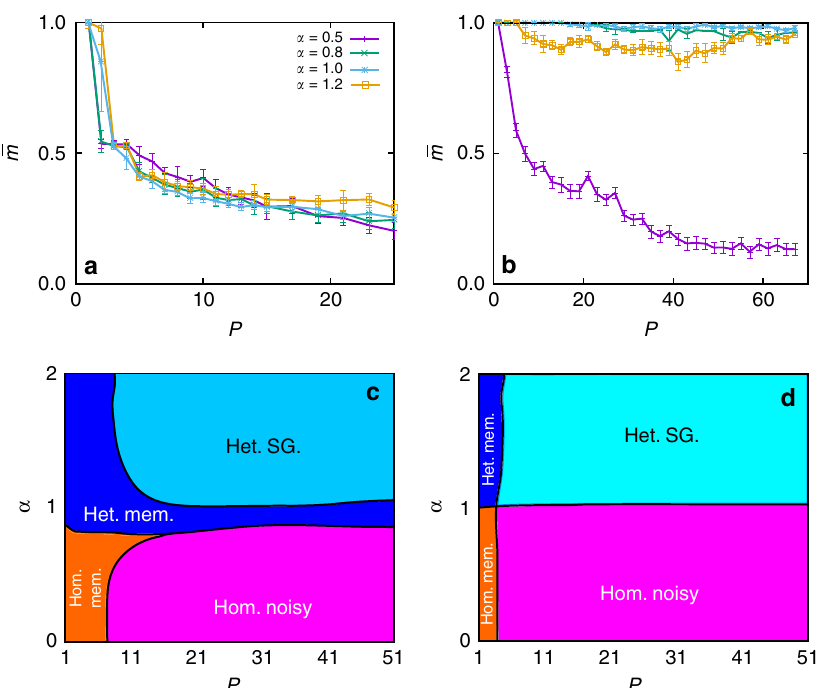
Fig. 5 Capacity analysis. Capacity curves ( T = 0) for ( a ) randomly distributed patterns ( a 0 = 0.5), and ( b ) patterns distributed in small sets of active neurons ( a 0 ≈ 1/ P ). m corresponds to the recovered pattern in each case. Results are for N = 800 and are averaged over 50 realizations, with other parameters as before. Error bars correspond to the s.d. c and d show the phase diagram of the system, obtained as in Fig. 4, as a function of α and P for the full model ( c ) and the topological limit ( d ). Data points have been averaged over 10 realizations